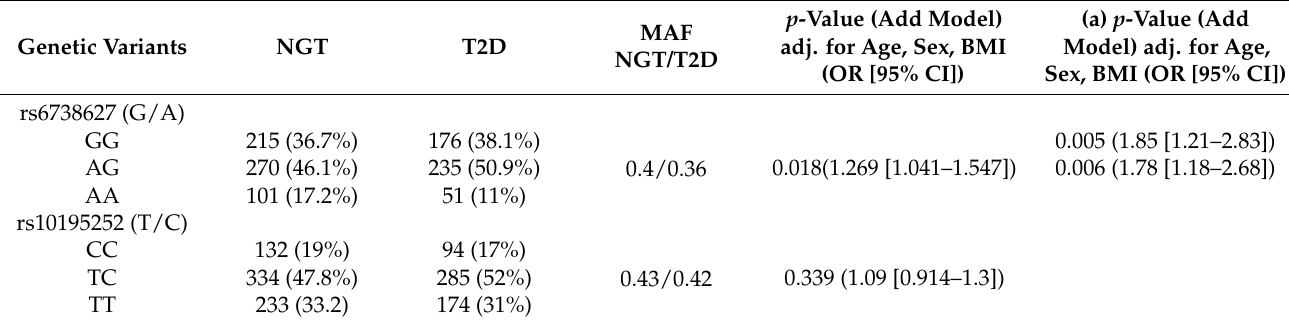
Table 1. Case control study for type 2 diabetes.